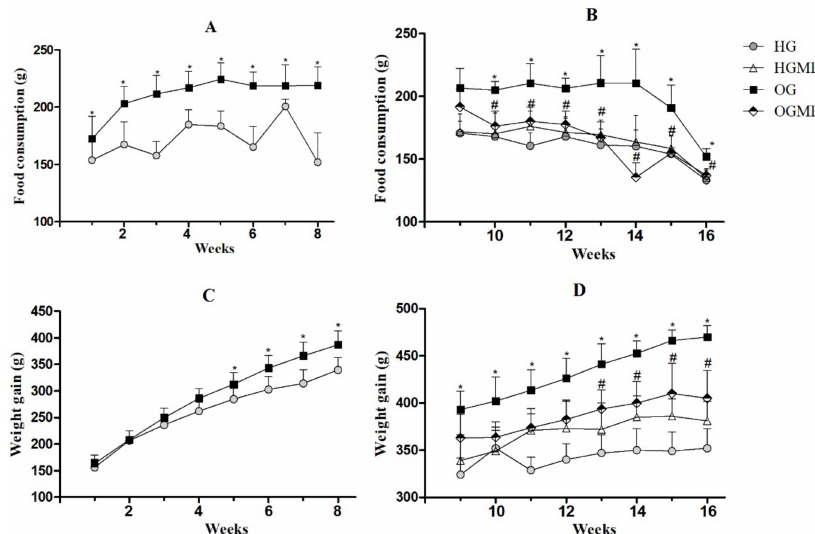
Figure 1. Food consumption ( A , B ) and weight gain ( C , D ) in healthy and obese rats in the pre- and post-administration period with MP seed extract. Data presented as mean and standard deviation of the mean. Two-way ANOVA, p ≤ 0.05 Tukey’s post hoc test. * di ff ered from HG; # di ff ered from OG.